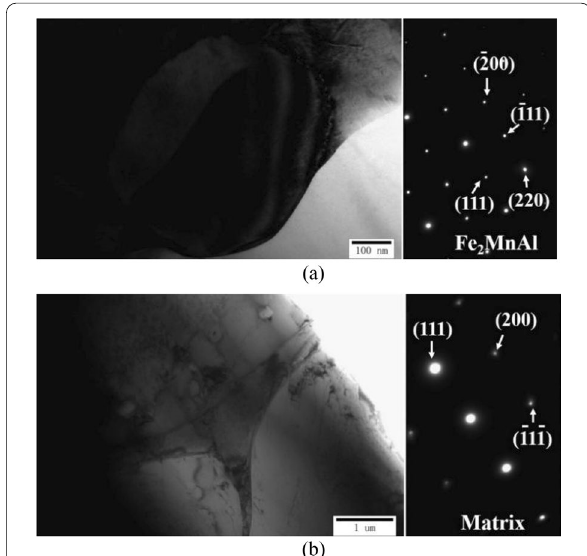
Figure 7 Microstructures of the CuMn 13 Al 7 sample formed by wire arc additive manufacturing: a matrix and corresponding SAED, b matrix phase and corresponding SAED